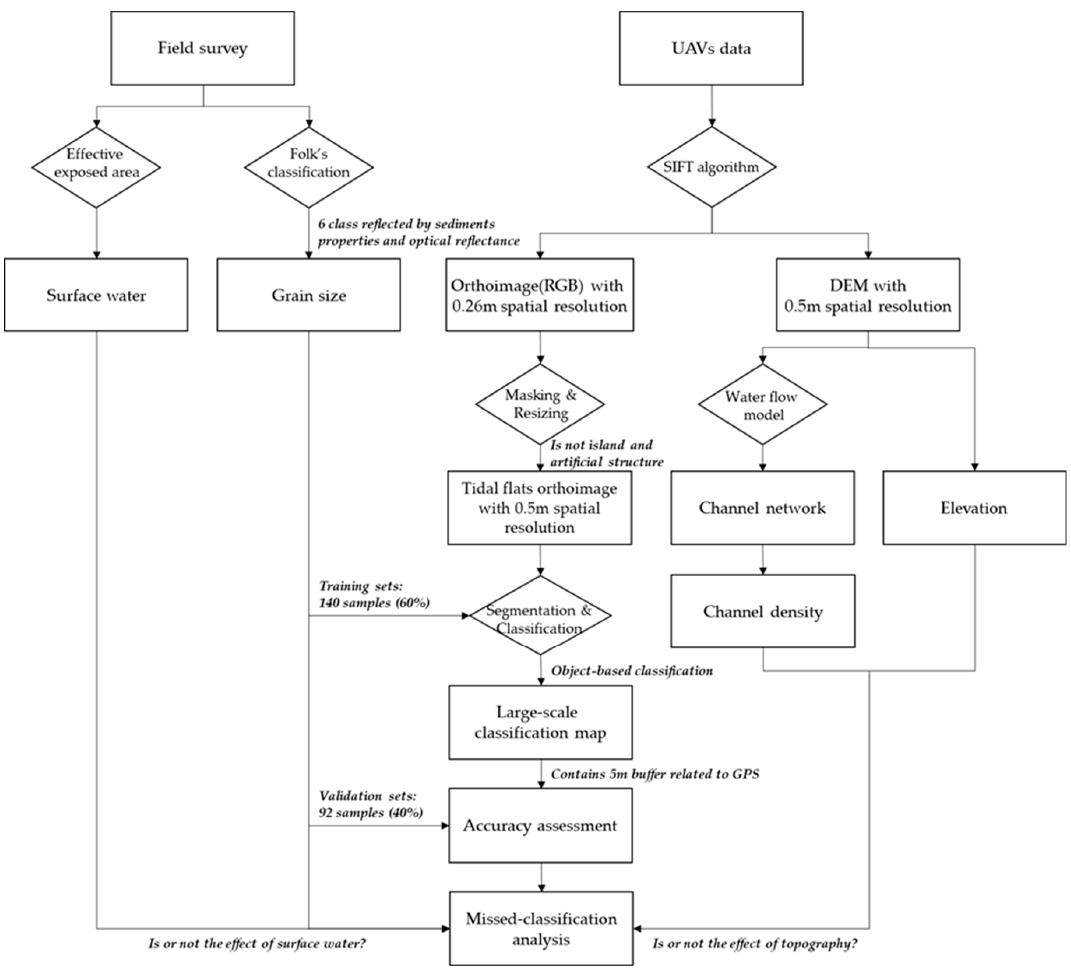
Figure 3 . Large-scale classification of surface sediment distribution using an UAV orthoimage (red, green, blue; RGB) combined with a field survey conducted at 232 sites. To map the large-scale sediment distribution, 140 and 92 samples were used as training and validation sets, respectively. The field survey produced the grain size, elevation, and surface water data, which were used to analyze the missed classification samples.